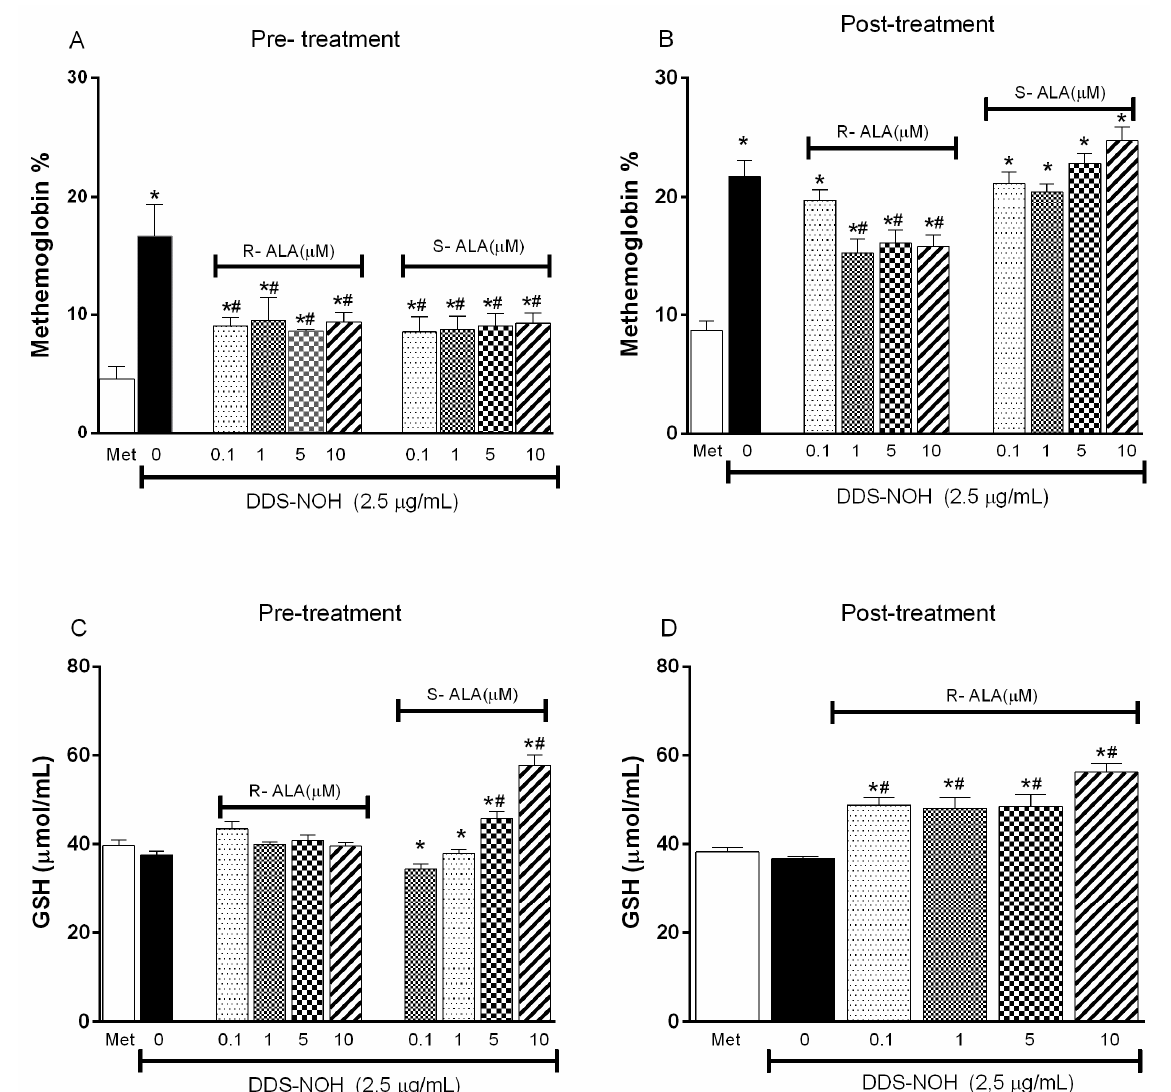
Figure 5. Effect of the pre ‐ or post ‐ treatment with R ‐ ALA or S ‐ ALA on methemoglobin formation and GSH production induced by DDS ‐ NOH. ( A ) pre ‐ treated ALA methemoglobin levels in different concentrations of R and S ‐ ALA; ( B ) post ‐ treated R and S ‐ ALA methemoglobin levels in different contractions; ( C ) glutathione levels in samples pretreated with different R and S ‐ ALA concentrations; ( D ) glutathione levels in samples post treated with different R and S ‐ ALA concentrations. Erythrocytes were pretreated or post ‐ treated with R or S ‐ alpha Lipoic Acid (R ‐ ALA or S ‐ ALA, 0.1, 1; 5 and 10 μ M) for 1 h at 37 °C and incubated for 30 min with DDS ‐ NOH (2.5 μ g/mL). Values are means ± S.E.M. * p < 0.05 compared to methanol. # p < 0.05 compared to the DDS ‐ NOH group.